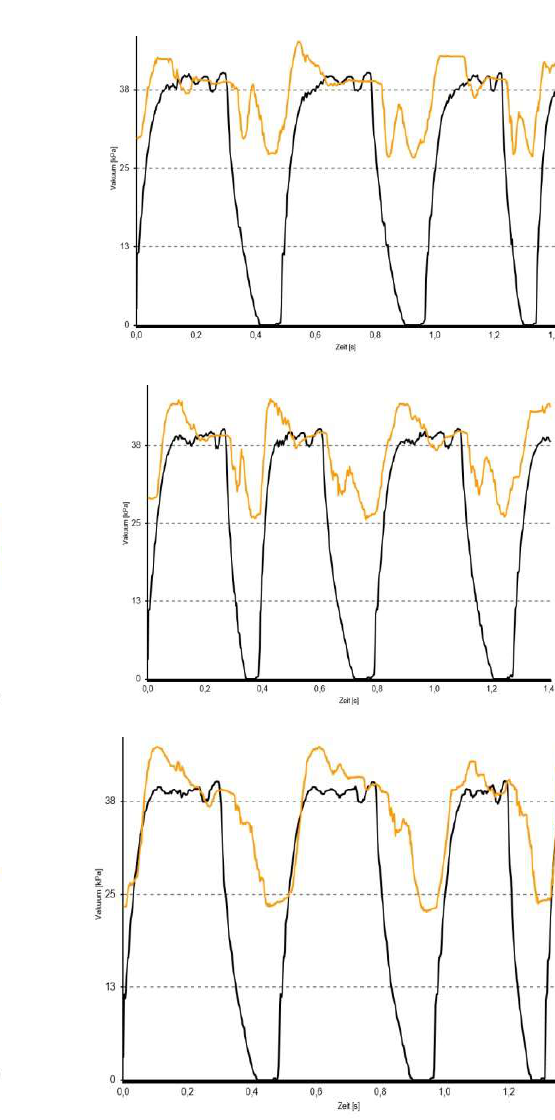
Figure 4. Cyclical vacuum fluctuations in the pulsation and inner chambers of the teat cup during milking the 1st WF in the sheep milking machine with the following settings: 40 vacuum level (kPa), 120 pulsation rate (cycles/min) and 60:40 pulsation ratio.